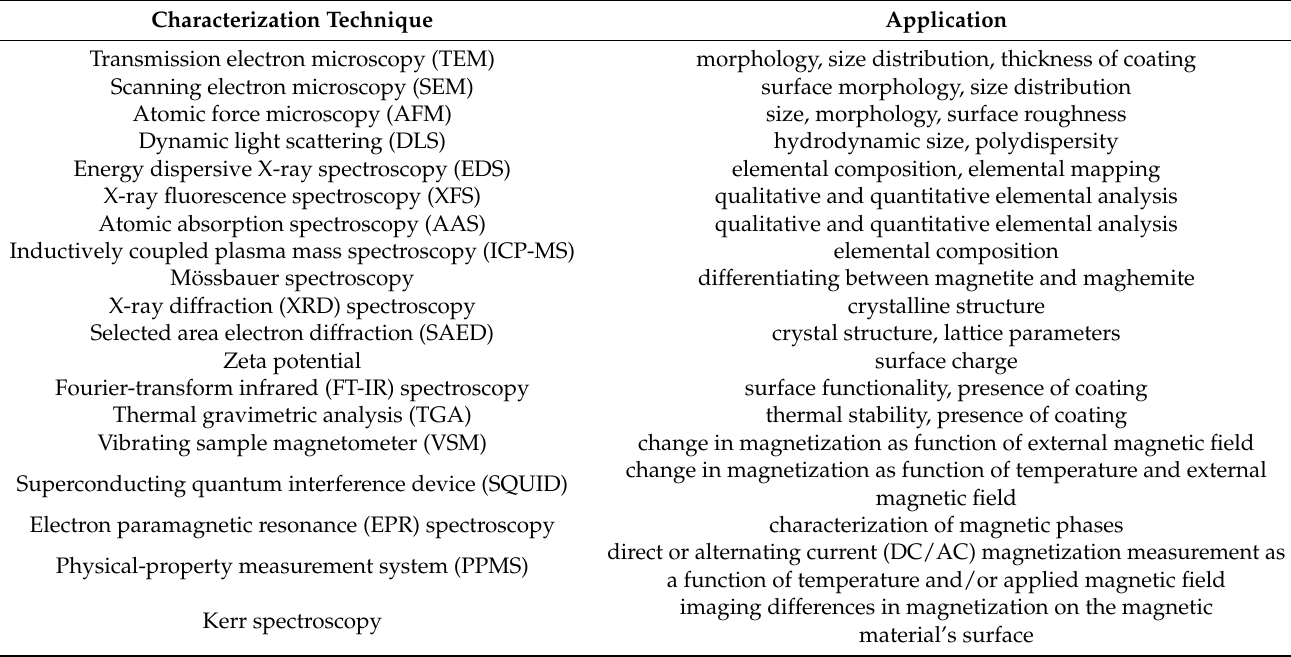
Table 2. Commonly used techniques for characterization of magnetic